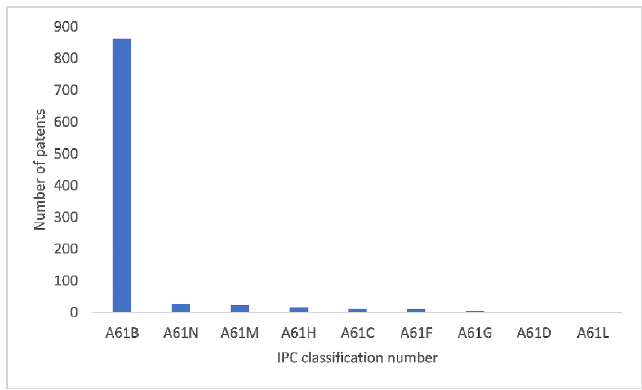
Fig. 12 Distribution of IPC in medical